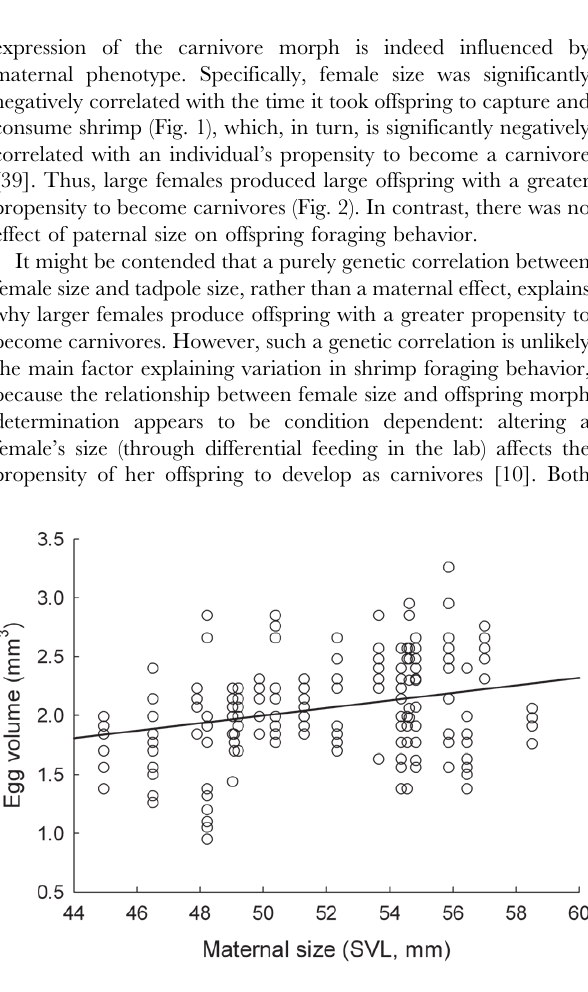
Figure 3. The relationship between maternal size and egg volume. Shown is maternal size (SVL) and egg volume for 20 families of S. multiplicata . Data points for individual eggs are shown.